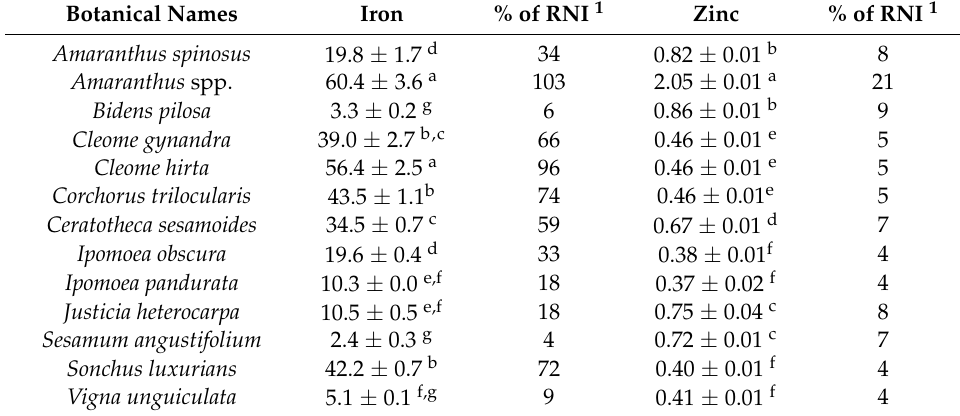
Table 4. Iron and zinc contents (mg/100 g fresh weight) of ILVs *.